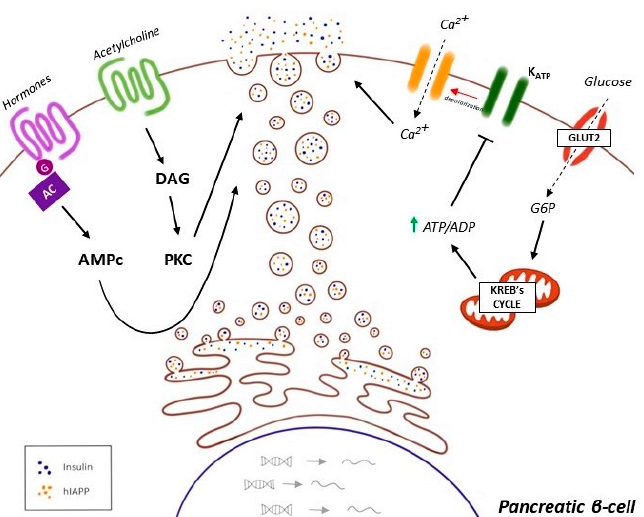
Figure 2. Mechanisms involved in insulin and hIAPP cosecretion in pancreatic β -cell. The most important physiological stimulus of insulin secretion is glucose. Glucose is transported inside the cell thanks to GLUT2, entering the Krebs Cycle and glycolysis. These processes produced a higher ATP/ADP rate that inhibits ATP-dependent K + channels, depolarizing the membrane. Changes in the potential of membrane open Ca 2+ channels, introducing Ca 2+ into the cell and promoting the release of the insulin into blood flow after glucose intake. Not only this pathway releases this hormone, but also an increment of AMPc via apetite’s hormones signaling and the activation of PKC, due to the adrenergic response. What is more important is that amylin or hIAPP is cosecreted in these insulin granules after its maturation in